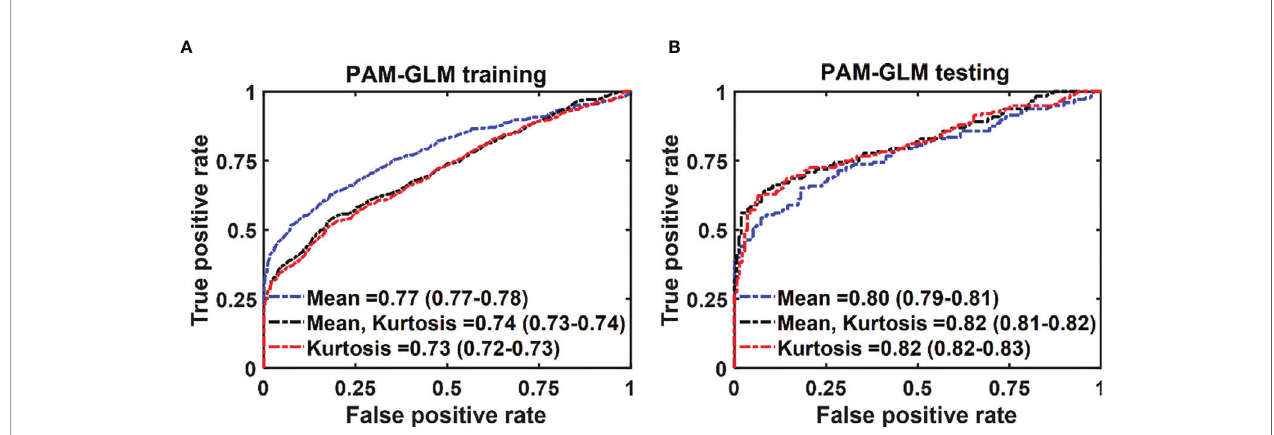
FIGURE 6 | The average ROC of the training (A) and testing (B) data sets for different combinations of features set. The features were extracted from PAM images. The 95% CIs are indicated in